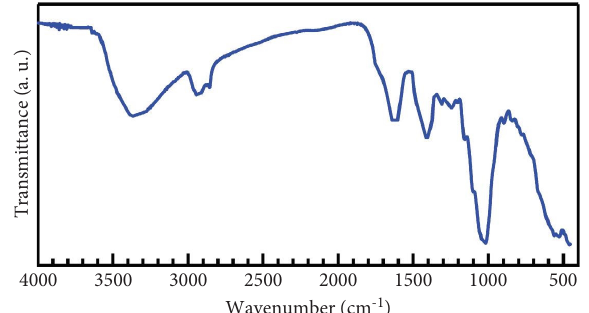
Figure 3: FTIR spectra of AgNPs using N. sativa extract.